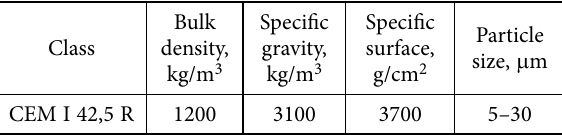
Table 1. Portland cement characteristics